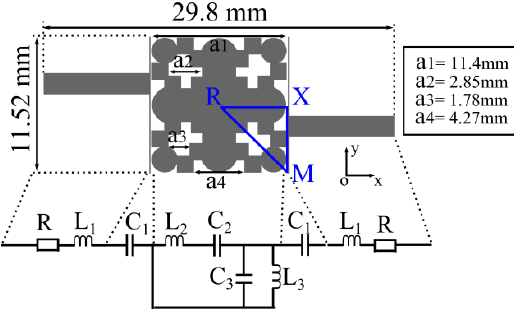
Figure 2. Layout of the band-pass filter (BPF) with its characteristic circuit model.